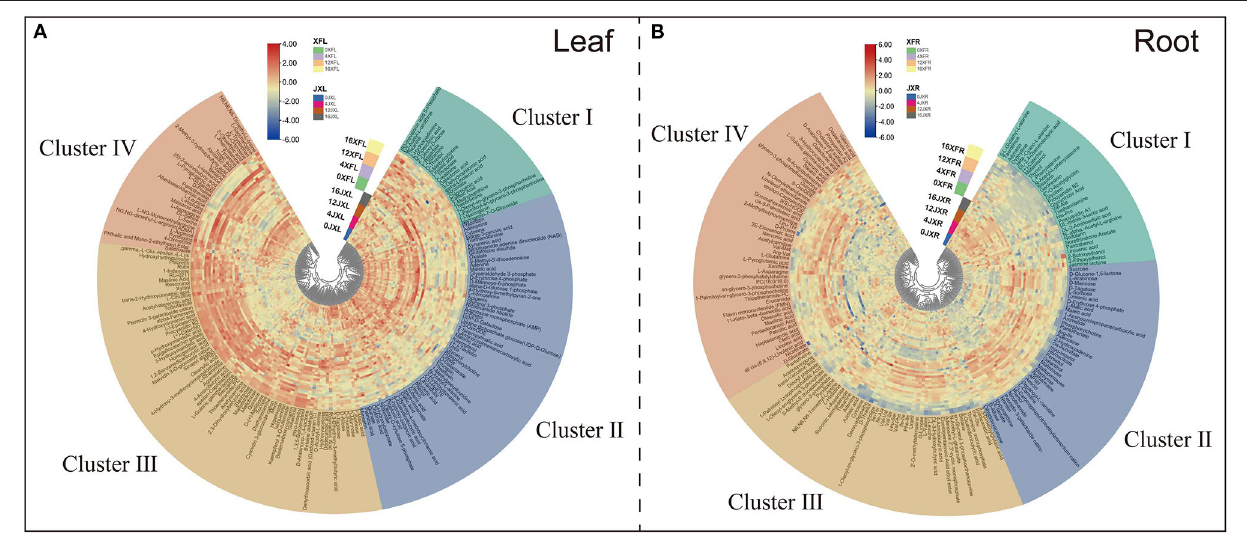
FIGURE 4 | Hierarchical clustering of 185 leaf differential metabolites (A) and 165 differential root metabolites (B) identified from two tea cultivars with different shading periods. From center to edge, unshaded “Jinxuan” leaves (0JXL), JX leaves after 4 days of shading (4JXL), JX leaves after 12 days of shading (12JXL), JX leaves after 4 days of regaining light (16JXL), the unshaded “Xiangfeicui” leaves (0XFL), XFC leaves after 4 days of shading (4XFL), XFC leaves after 12 days of shading (12XFL), XFC leaves after 4 days of regaining light (16XFL); JX roots when unshaded (0JXR), JX roots after 4 days of shading (4JXR), JX roots after 12 days of shading (12JXR), and JX roots after 4 days of regaining light (16JXR), XFC roots when unshaded (0XFR), XFC roots after 4 days of shading (4XFR), XFC roots after 12 days of shading (12XFR), XFC roots after 4 days of regaining light (16XFR). Each sample has six biological replicates (1–6). The metabolite levels changed, and they could be organized into four clusters named clusters I, II, III, and IV. Blue indicates relatively low intensity, while red indicates relatively high intensity.